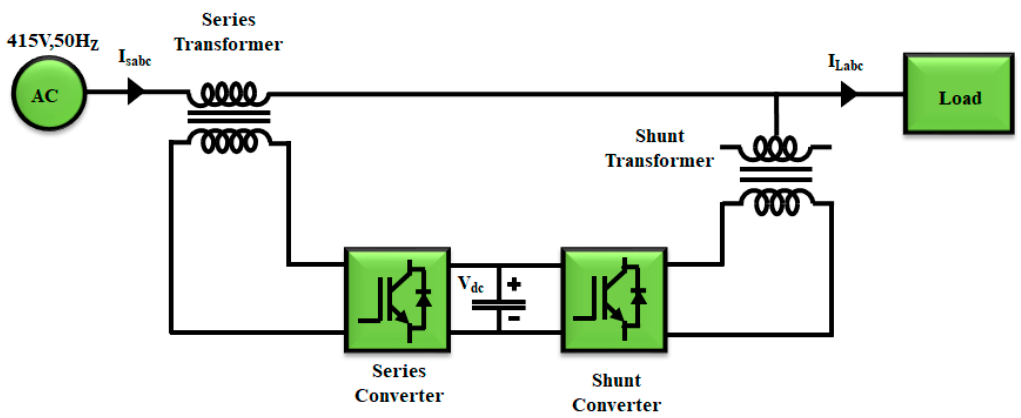
Figure 5. Representation of UPFC.